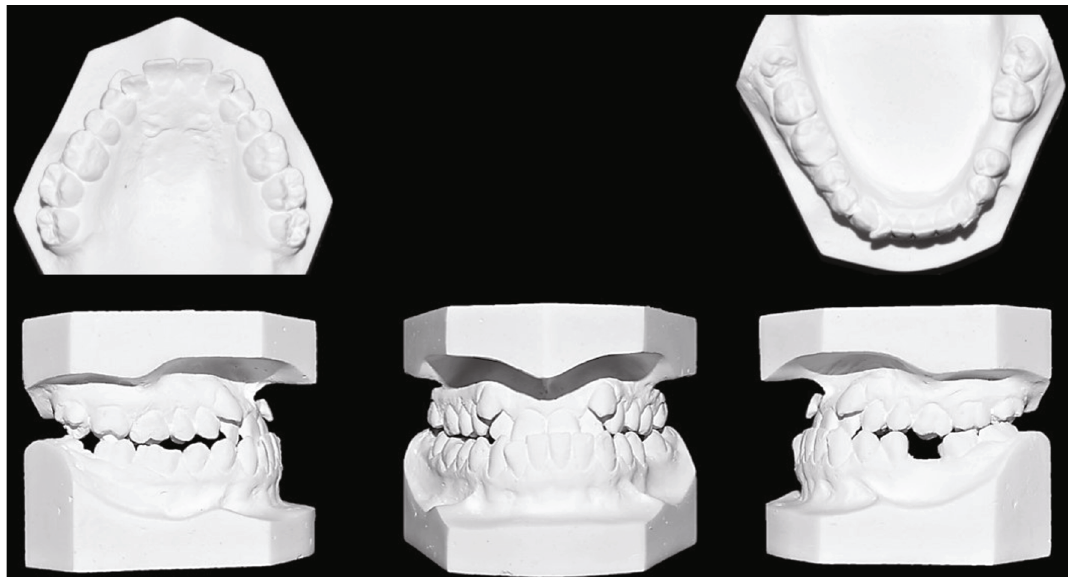
Figure 2: Pretreatment